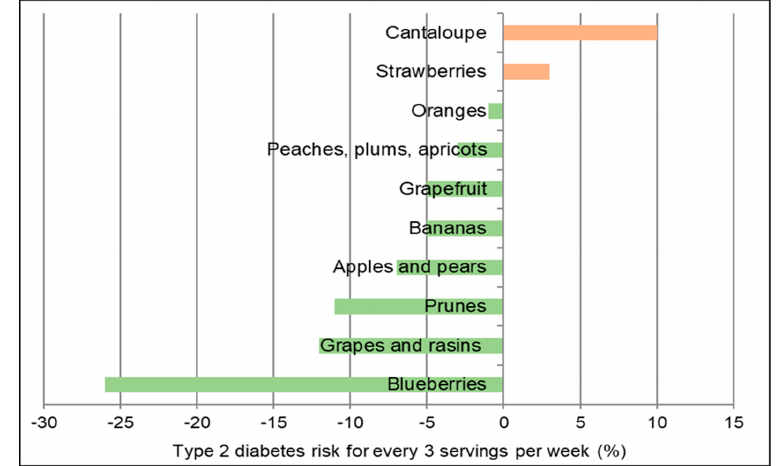
Figure 13. Effect of 3 servings per week of fruit varieties on type 2 diabetes (diabetes) risk from pooled data from US men and women in the Nurses’ Health Studies and the Health Professionals Follow-up Study [208].